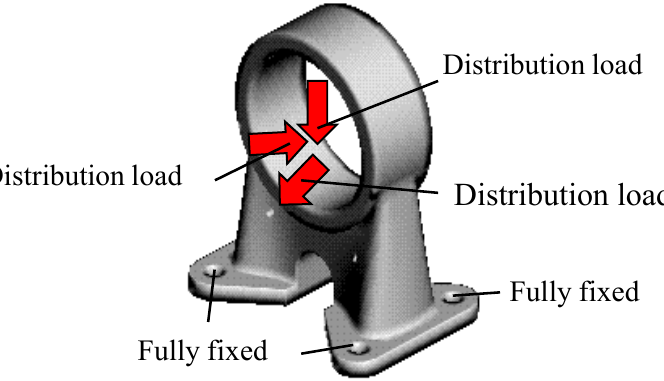
Figure 9. An engine mount bracket for fixing a passenger car engine.